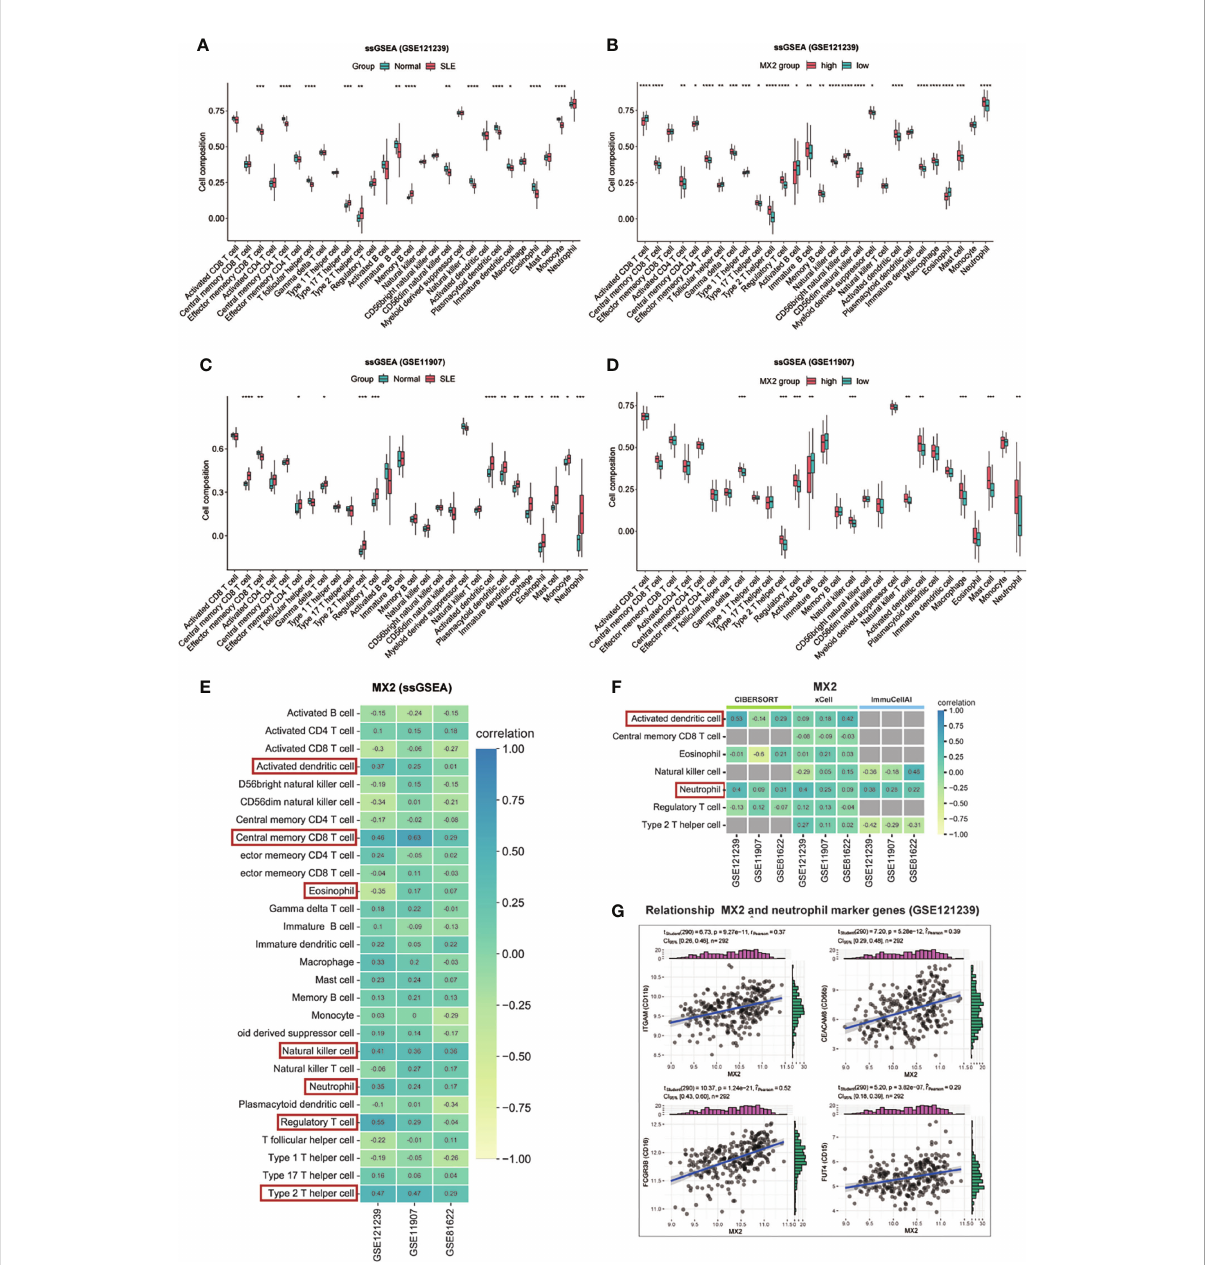
FIGURE 7 MX2 was mainly positively associated with neutrophil in fi ltration. (A) , (C) Comparison of the ssGSEA scores for immune cells estimated between all samples with Normal and SLE in the GSE121239. (B) , (D) Comparison of the ssGSEA scores for immune cells estimated between patients with high and low MX2 expression subgroups in the GSE121239. (E) Correlation between MX2 and in fi ltrating immune cells in three datasets (ssGSEA). (F) Correlation between MX2 and seven types of in fi ltrating immune cells in three datasets (CIBERSORT, xCell and ImmuCellAI). The gray area indicates that the algorithm does not contain this type of cell. (G) Correlation between MX2 and neutrophil marker genes. (*P <0.05, **P <0.01, ***P <0.001, ****P